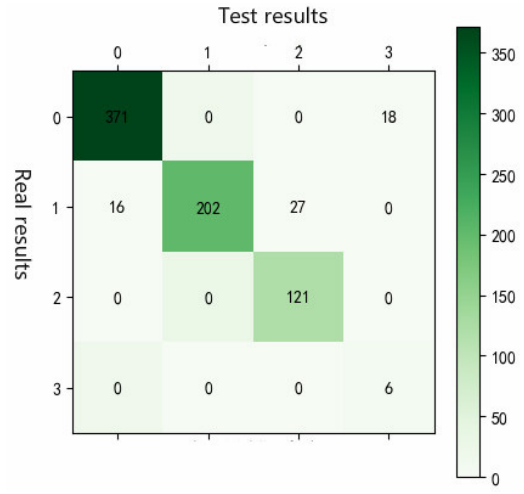
Figure 8. Confusion matrix diagram of warning results.